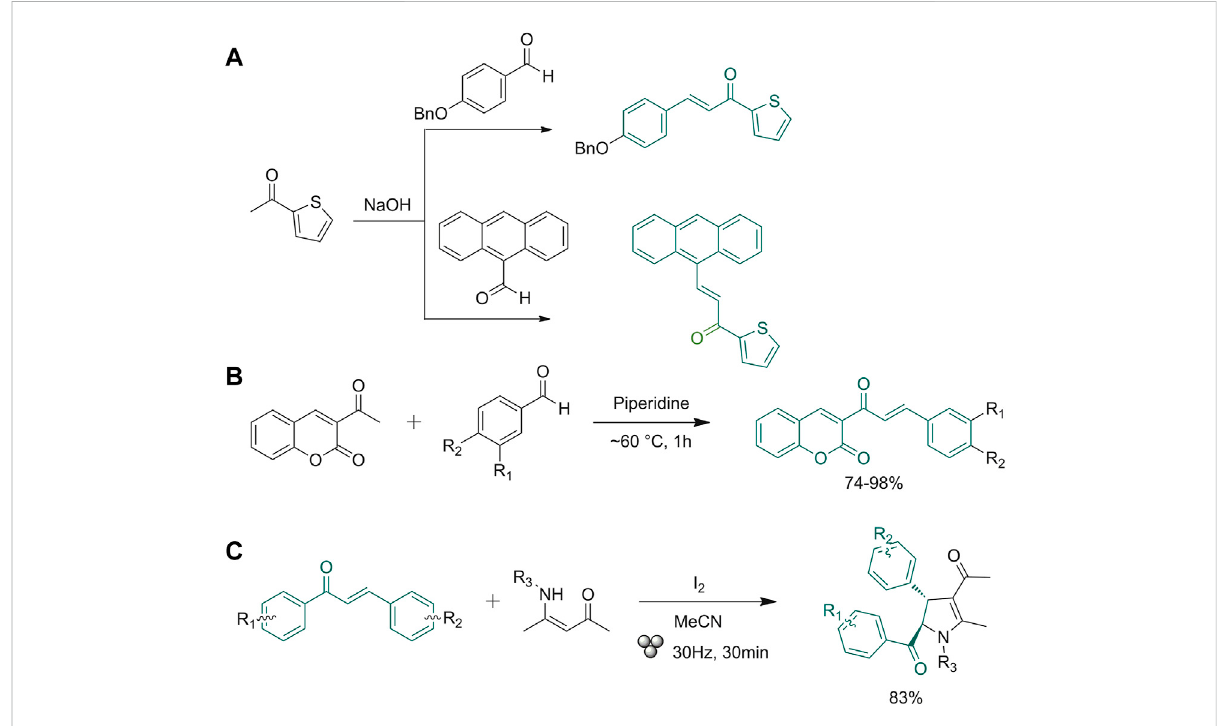
FIGURE 2 (A) Synthesis of anthracene- and 4-benzyloxy-based chalcones; (B) Claisen-Schmidt condensation between 3-acetyl-2 H -chromen-2-one mono- and disubstituted benzaldehydes; (C) synthesis of polysubstituted 2,3-dihydropyrroles (relative stereochemistry is